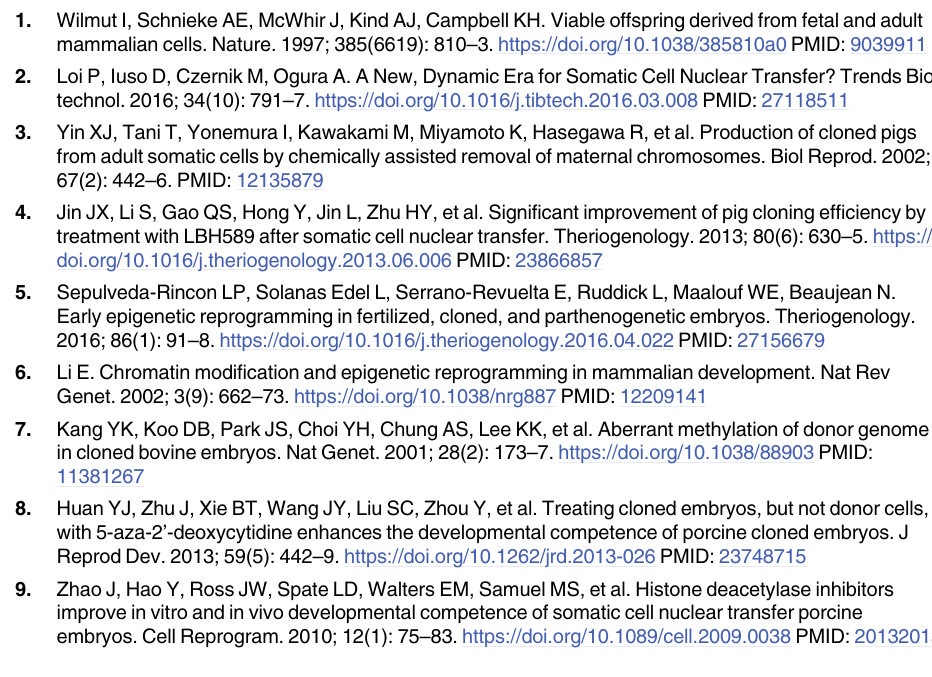
S1 Table. Sequence information on porcine-specific primers for quantitative real-time polymerase chain